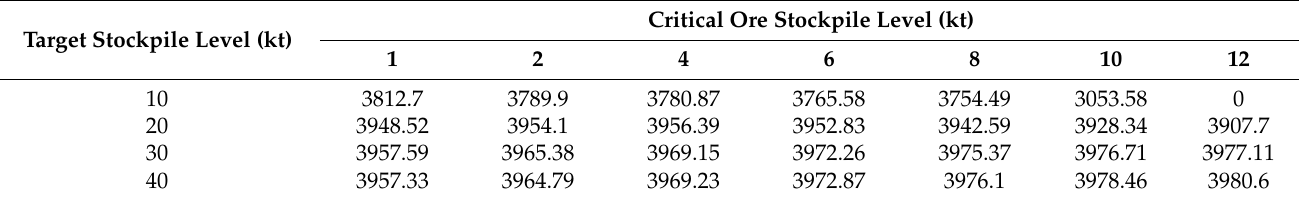
Table 5. Summary of the average simulation throughputs in tons/day.